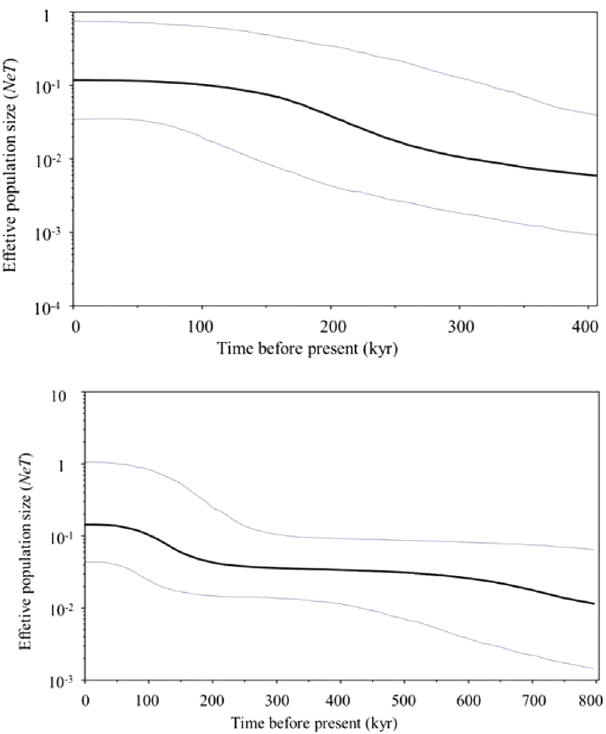
Fig. 7. Bayesian skyline analysis of lineage land lineage 2 (from top to